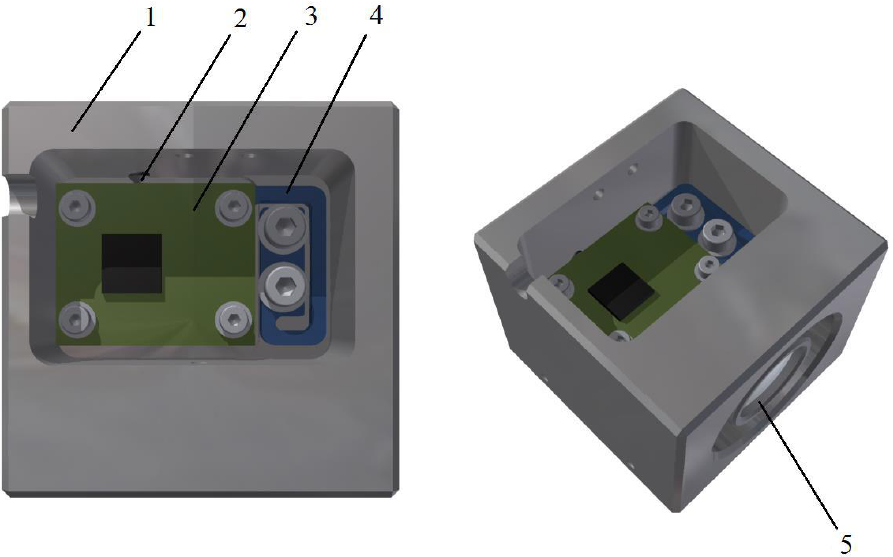
Figure 1. Structure of the tilt sensor: 1—housing; 2—aligning screw, 3—PCB with MEMS accelerometer; 4—aligning unit; 5—spirit level.